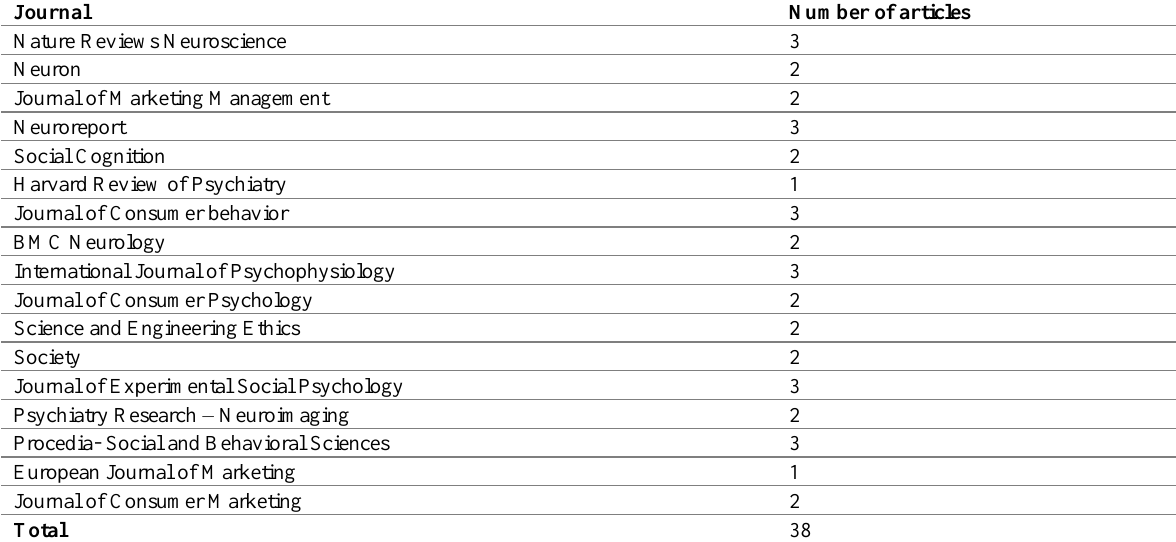
Table 1: Number of articles